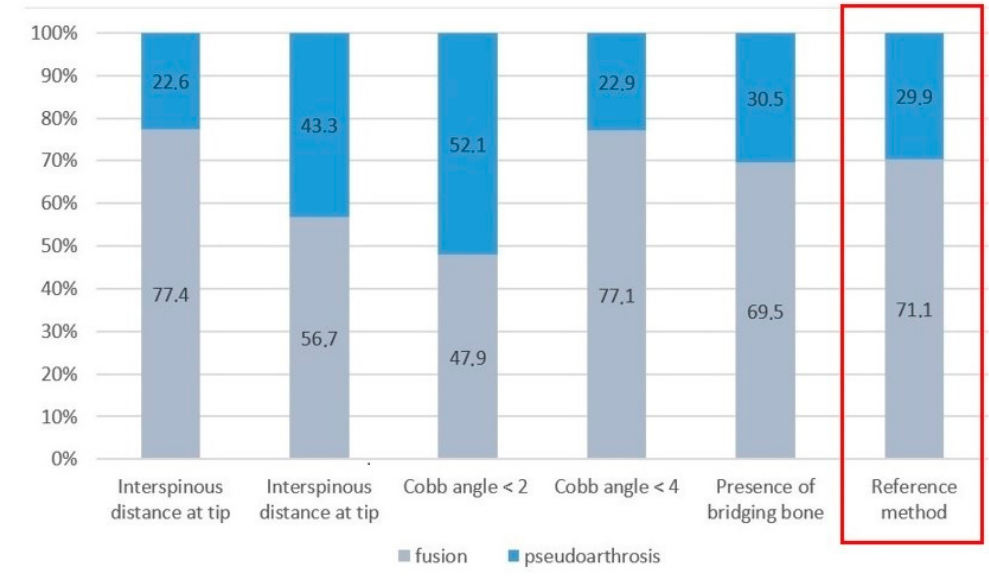
Figure 5. Fusion rates in percentages according to various assessment methods.